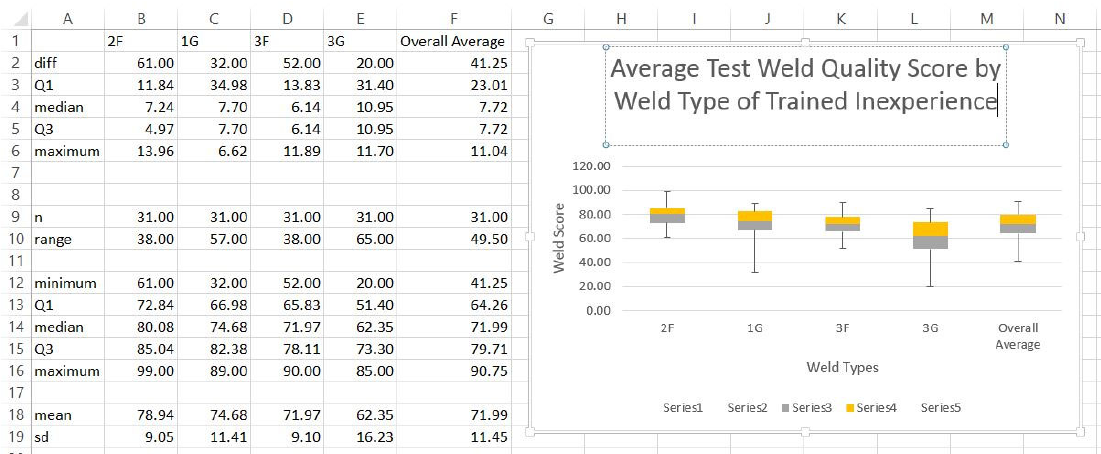
Fig. 6. Average SMAW test weld quality score by weld type of trained inexperienced